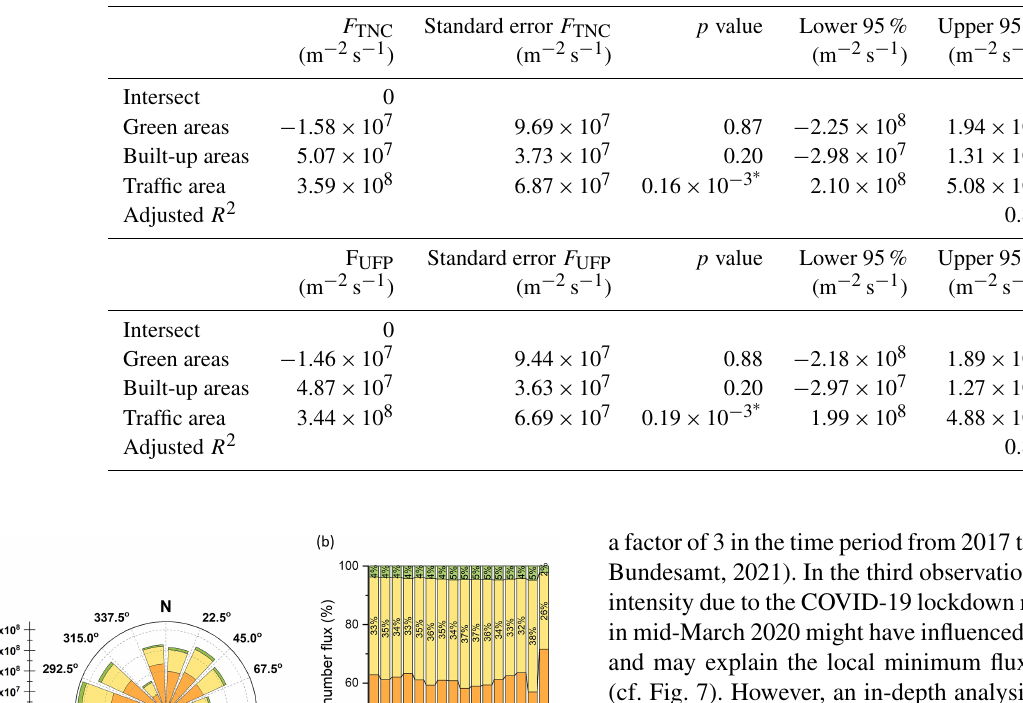
Table 4. Coefficients of the LUR analysis concerning F TNC and F UFP in the different wind sectors. Significant variables (significance level p < 0.001) are highlighted (*).